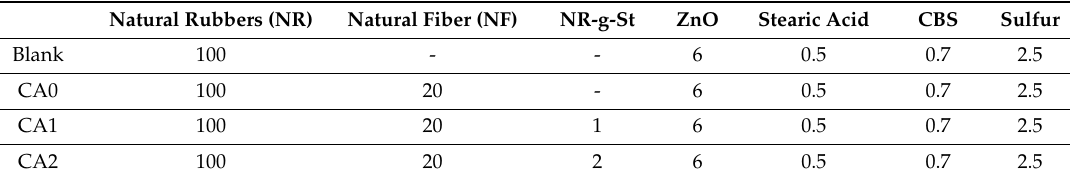
Table 1. Compositions of prepared samples (in